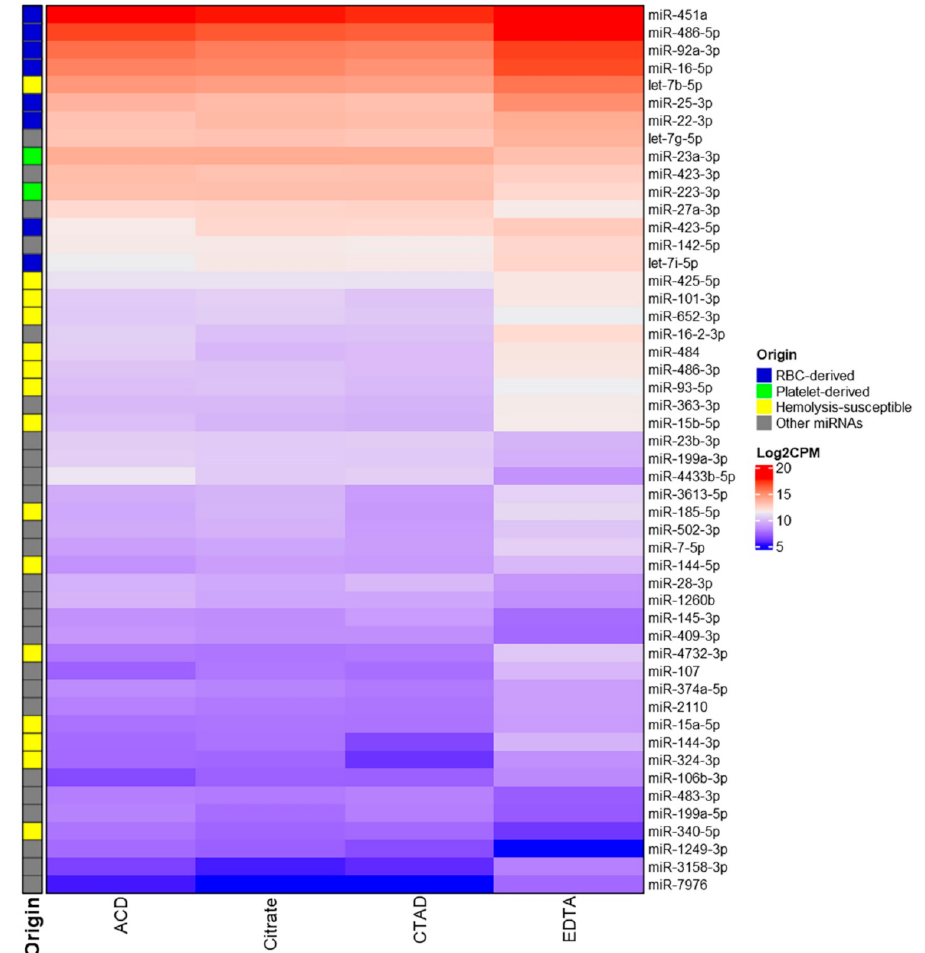
Figure 7. The heatmap of the log 2 CPM values for differentially expressed miRNAs in the study groups. The potential origin of miRNAs corresponds to the terms “RBC-derived miRNAs” and “Platelet-derived miRNAs” based on the top 10 miRNAs in each cell type (see Section 2.3.4), “Hemolysis-susceptible miRNAs” based on the additional miRNAs linked with hemolysis based on the previous studies, or indicate other miRNAs not belonging to these groups (“Other